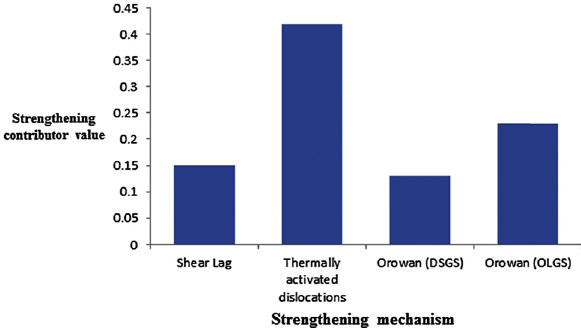
Figure 6: Comparison of strengthening mechanism factor on enhancing the tensile yield strength of shear lag, thermally acti - vated dislocations, Orowan looping disc - shaped graphene sheets ( DSGS ) , and Onion - like graphene sheets ( OLGS ) . Reproduced from ref. [ 63 ] .